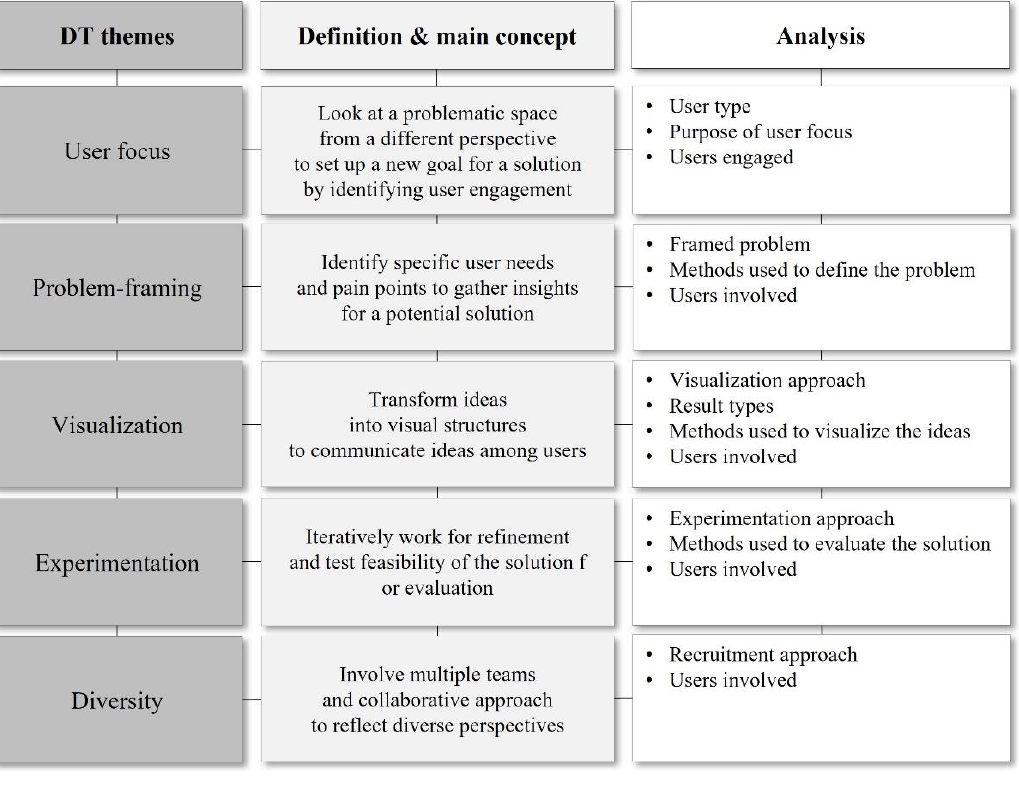
Figure 2. The DT themes representing methodological concepts.